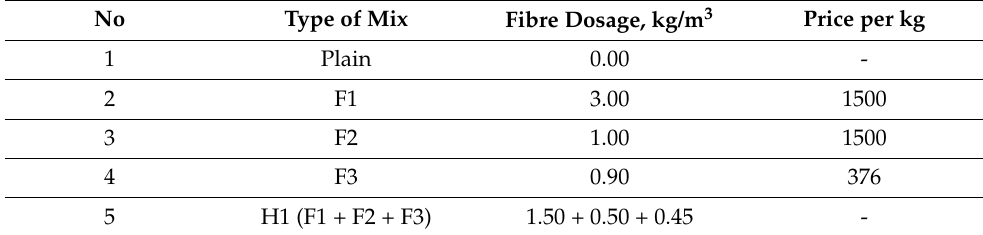
Table 3. Dosage of fibres in kg/m 3 and retail price.